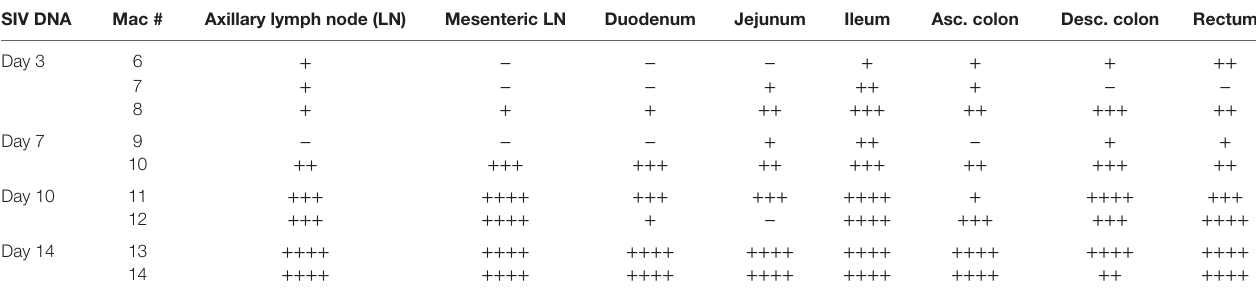
TaBle 1 | Quantification of simian immunodeficiency virus (siV) Dna in tissues sampled from siV-infected rhesus macaques. siV